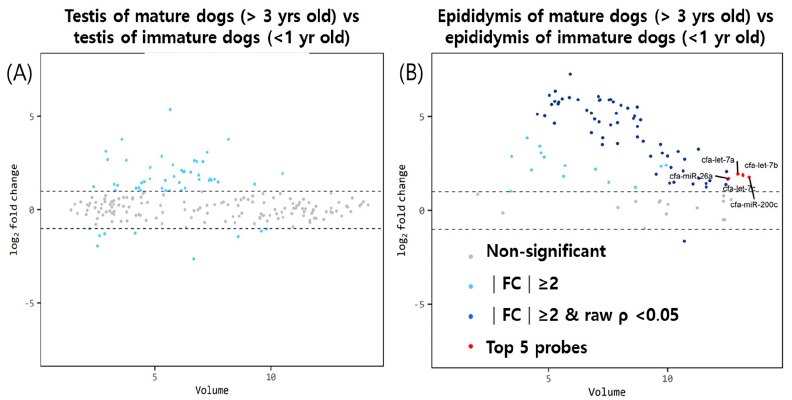
Figure 2. Volume plots of miRNAs in the ( A ) testis and ( B ) epididymis of mature 3 − year − old dogs (above) compared with those of immature 1-year-old dogs (below). The volcano plot illustrates the fold changes and volumes between the healthy immature and mature dogs. The horizontal line indicates a 2 − fold difference. The red dots indicate the significance of the top five miRNAs for comparison. The blue and sky-colored dots represent significant differences above a 2 − fold change without a p -value of <0.05. Cfa-miR = Canis lupus familiaris microRNA. Gray dots signify no meaningful correlation between volume and fold